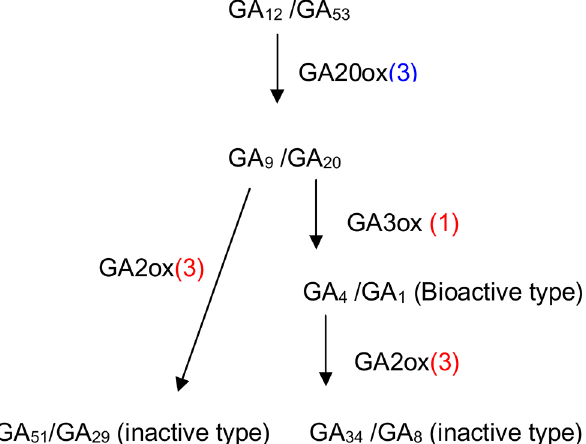
Fig 9. Gibberellin metabolism in ‘ Meyer ’ under cold stress. GA20ox, GA 20-oxidase; GA3ox, GA3-oxidase; GA2ox, GA 2-oxidase. Numbers in brackets represent numbers of unique transcripts regulated by cold stress. Red and blue indicate up- and down-regulated by low temperature,